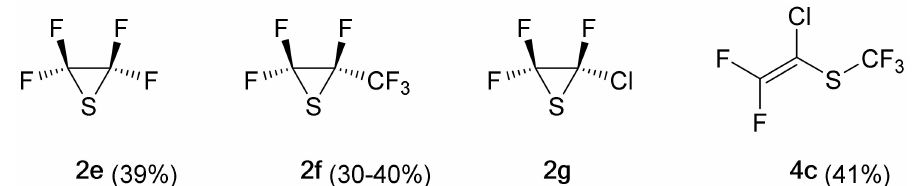
Figure 1. Products of the reactions of perfluoropropenoxide with difluorothiophosgene, trifluoro- thioacetyl fluoride, monofluorothiophosgene, and trifluoromethyl dithiochloroformate, respectively. A superior method for the preparation of fluorinated thiiranes is the 1,3-dipolar electrocyclization (1,3-DE) of transient, fluorinated thiocarbonyl S -methanides 7 , generated from the corresponding 1,3,4-thiadiazolines 6 (Scheme 3, Table 1). The latter heterocycles are smoothly formed via [3+2]-cycloaddition of a thiocarbonyl compound as dipolarophile with diazomethane derivatives 5 . The fluorine atom or a fluoroalkyl group may originate either from one or from both reaction partners.